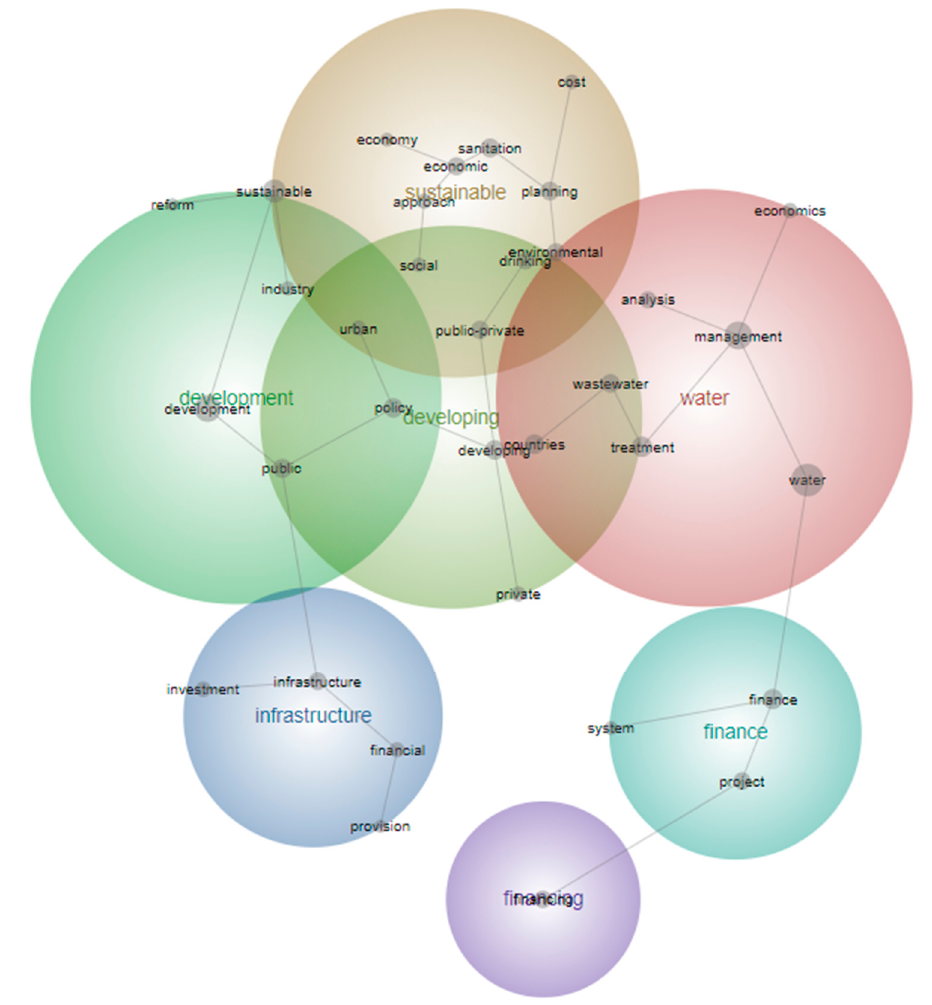
Figure 6. Leximancer’s concepts map.